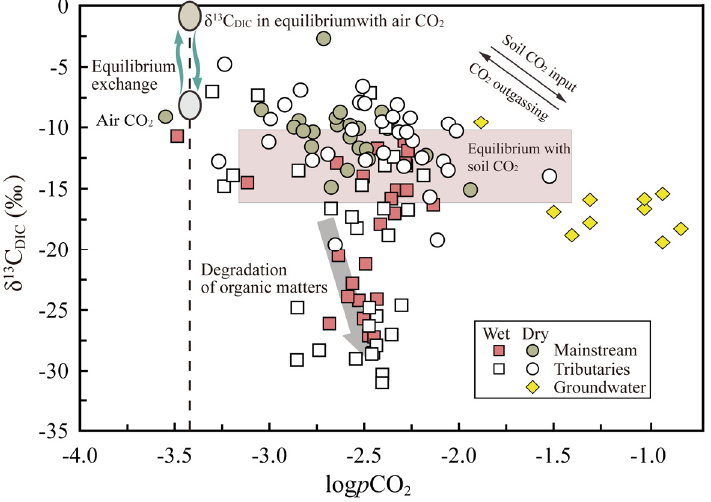
Figure 7. Relationship between the δ 13 C DIC and log p CO 2 for the water collected from the Mun River watershed in two seasons.